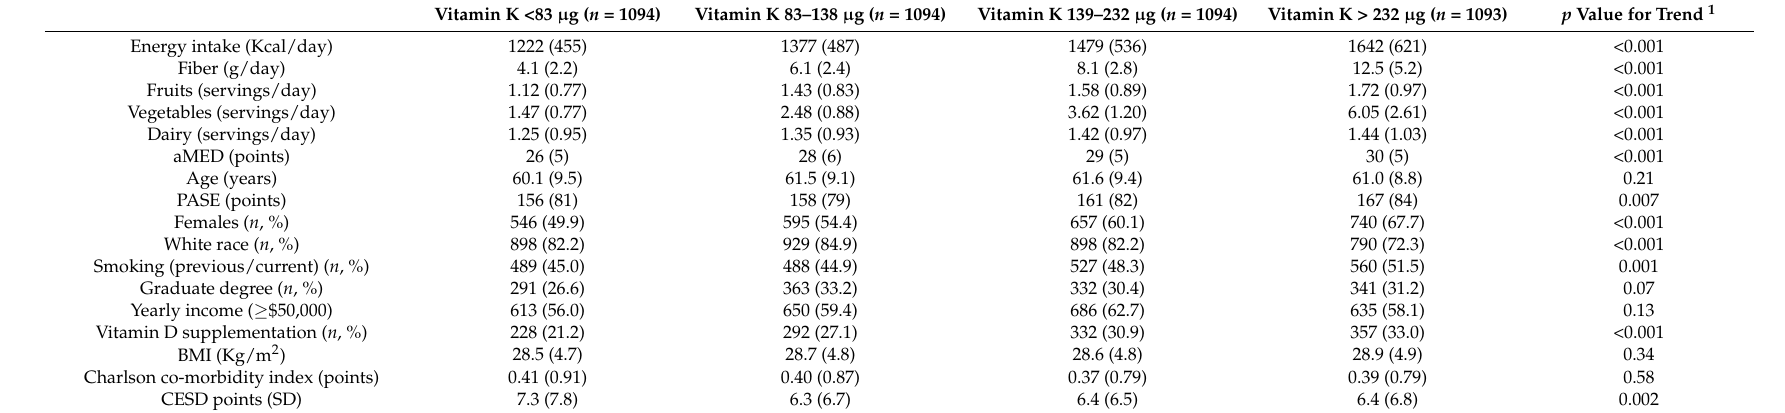
Table 1. Characteristics of the participants classified according to their dietary vitamin K intake.